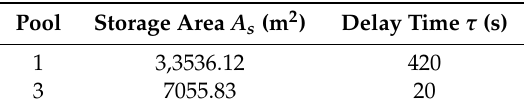
Figure 5. Schematization of a modeled canal reach by the integral delay (ID) model. Table 4. Parameters of the integral delay (ID) model.